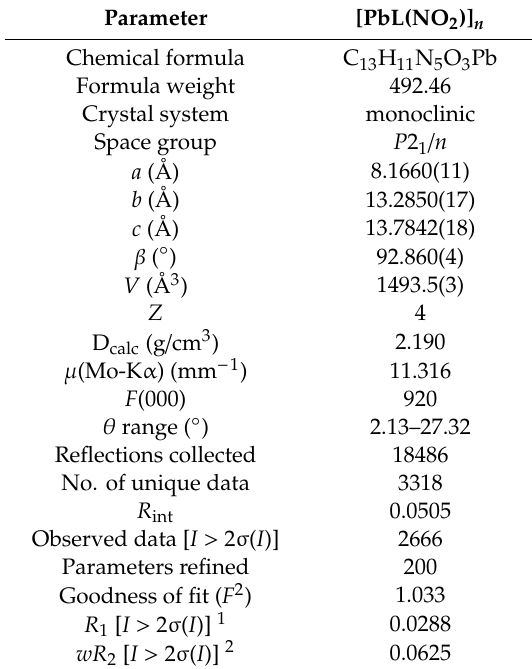
Table 5. Crystallographic data for [PbL(NO 2 )] n